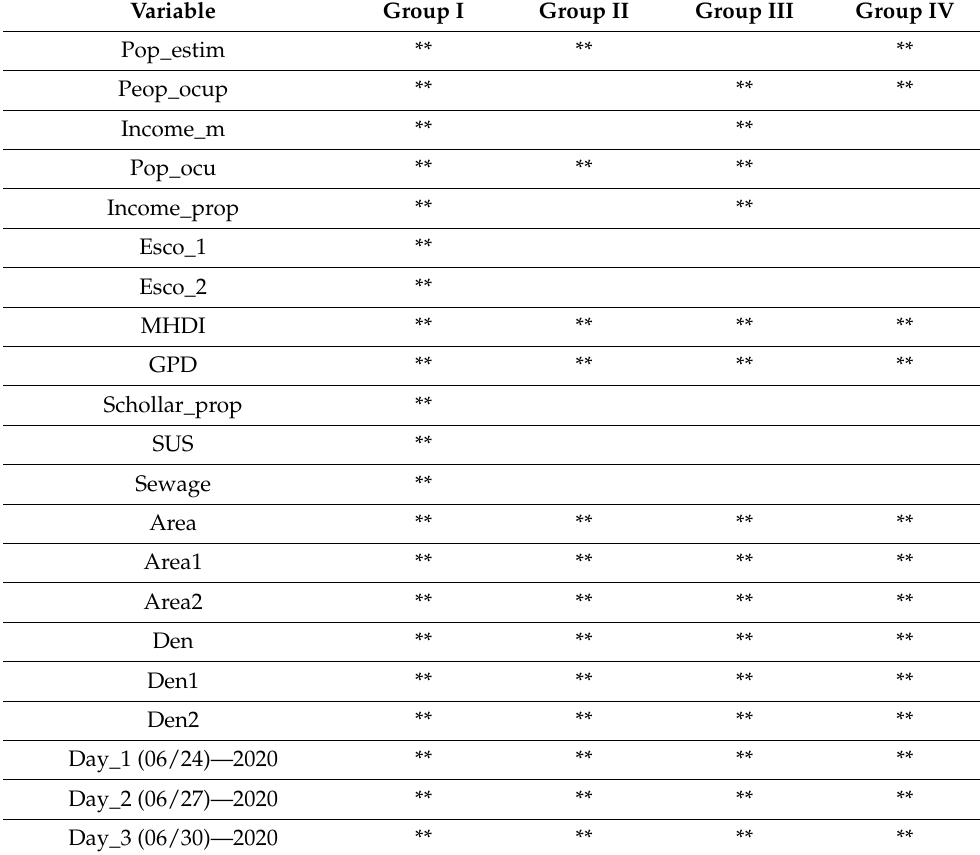
Figure 1. Study area: ( a ) Brazil borders; ( b ) The 26 Brazilian federative units and the federal capital, highlighting (red color) units that belong to the northeast region of Brazil; and ( c ) 1793 municipalities in the nine northeastern states. Table 3. Groups and